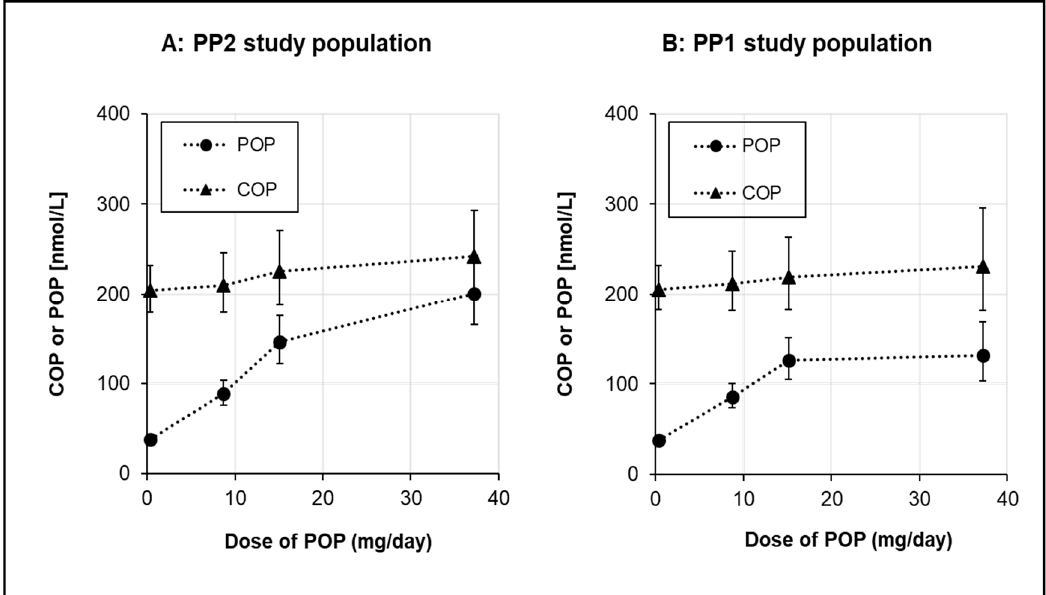
Figure 4. Serum total COP concentrations and stabilized concentrations of serum total POP with increasing dietary intakes of POP. Data are presented as mean plus 95% CI. Total COP and POP refer to the sum of all COP and POP measured including 7-keto and 7 α - and 7 β - OH derivates of PS and cholesterol, respectively. Stabilized total POP concentration refers to the steady-state serum concentration as modelled over the six-week intervention. For PP2 study population ( A ): n = 52 ( n = 14 in control, n = 15 in low POP dose, n = 13 in medium POP dose and n = 10 in high POP dose group) For PP1 study population ( B ): n = 59 ( n = 14 in control, n = 15 in low POP dose, n = 15 in medium POP dose and n = 15 in high POP dose group)